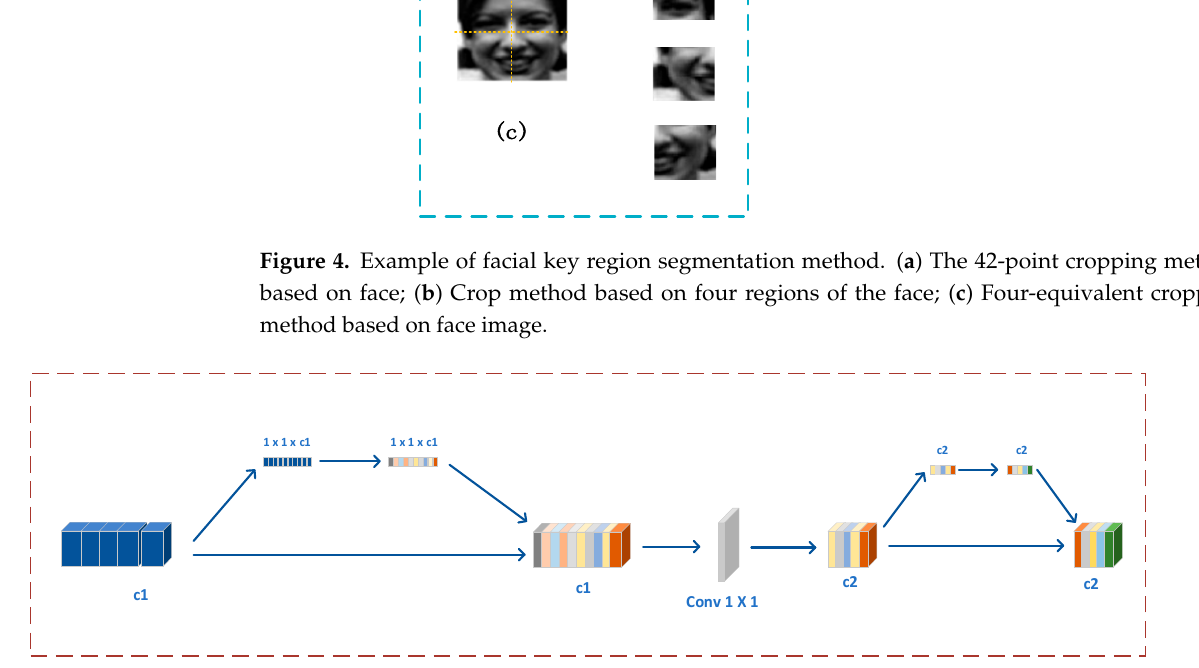
Figure 5. SA consists of two channel attention networks and a 1 × 1 convolutional neural network conv 1 × 1. DPSAN accomplishes the weighting of five different regions through the channel attention mechanism.